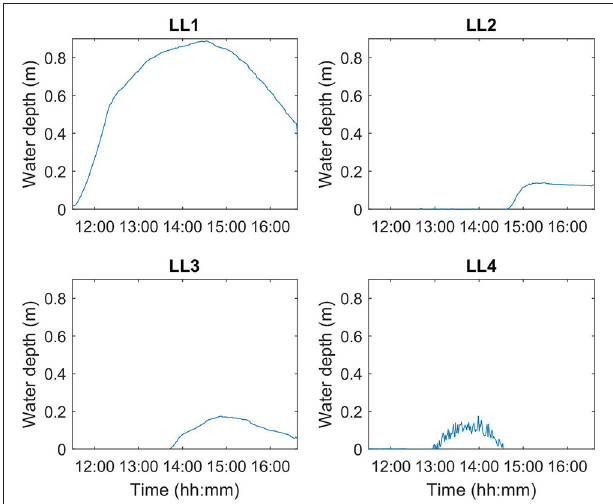
FIGURE 5 | Measured inundation heights (m) on 15 March 2014 for the sites as indicated in Figure 2 . Heights (m) are derived from the pressure sensor measurements, corrected for variations in atmospheric